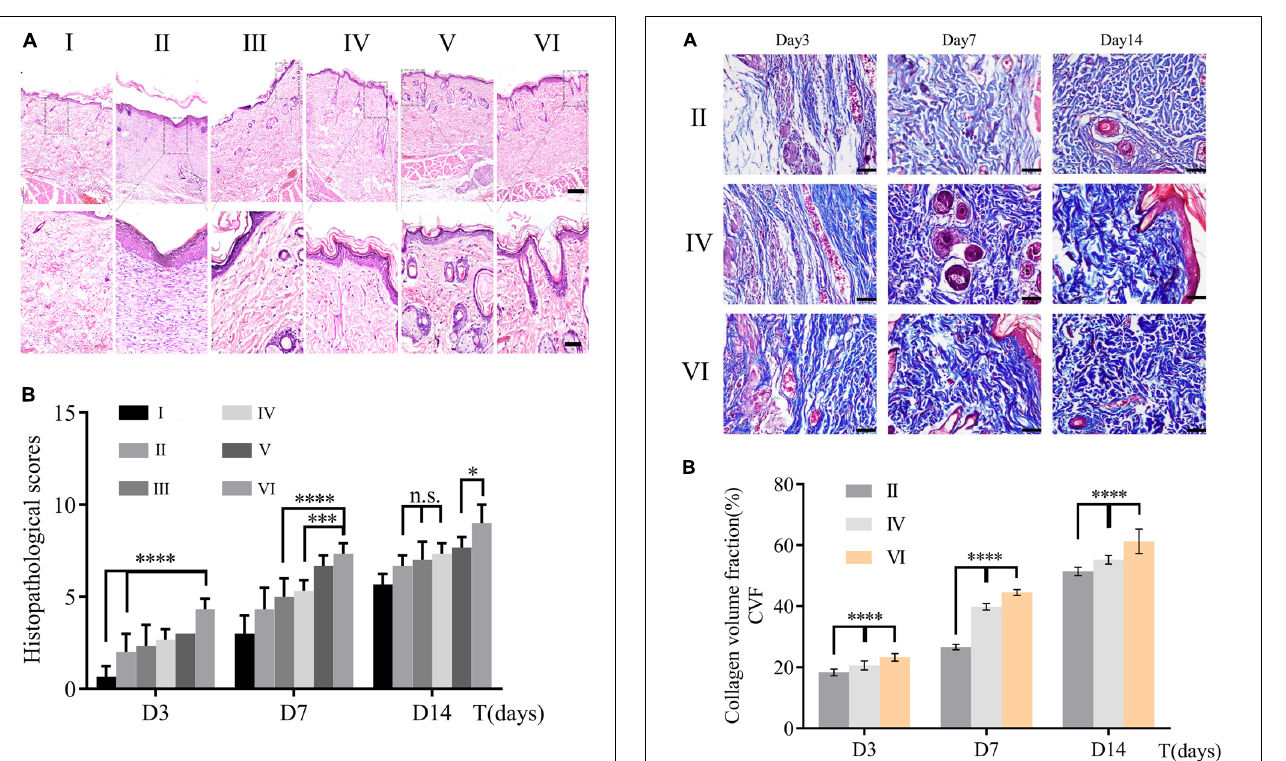
FIGURE 7 | (A) HE staining of wound section on day 14. The scale bar of the upper panel is 200 µ m; nether, 50 µ m. (B) Histopathological scores were calculated by HE staining on day 3, 7, and 14. ( n = 3, data = mean ± SD.) (I: blank control; II: NIR; III: HA hydrogel; IV: HA hydrogel + NIR; V: CuS/HA hydrogel; and VI: CuS/HA hydrogel + NIR).